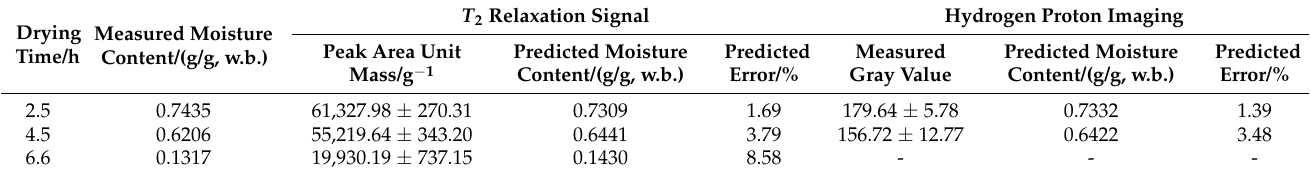
Table 2. Comparison of the predicted and measured moisture content of soybean dregs. Drying Measured Moisture Time/h Content/(g/g,